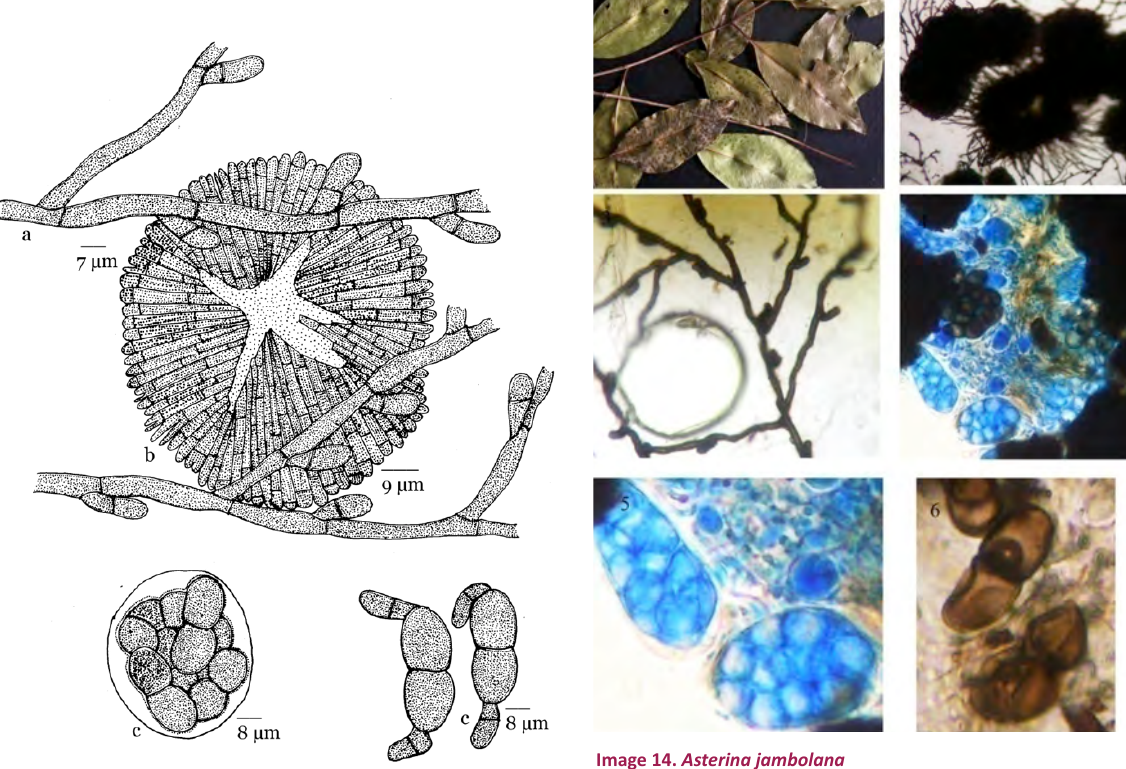
Figure 149. Asterina jambolana a - Appressorium; b - Thyriothecium; c - Ascus; d - Ascospores